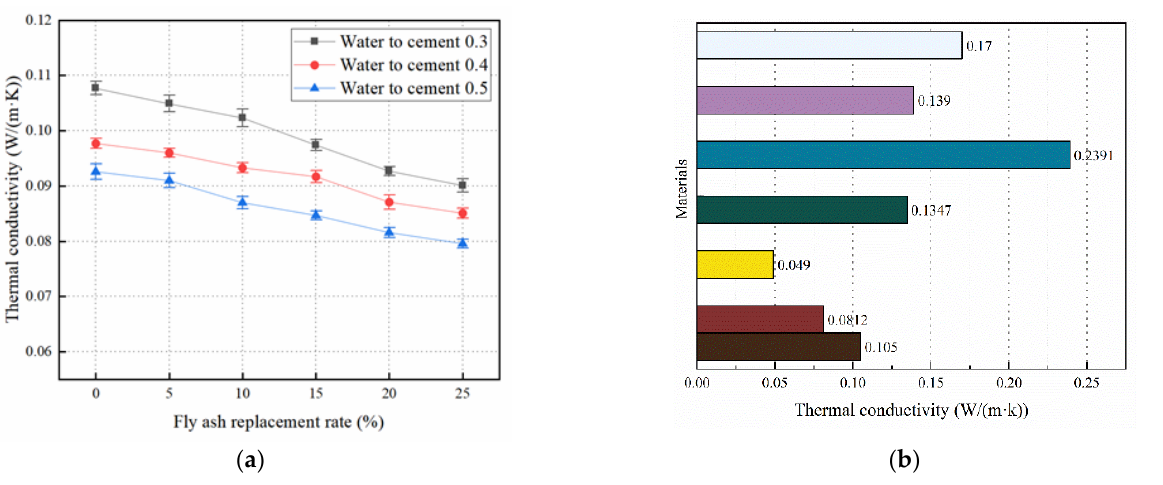
Figure 9. ( a ) Thermal conductivity of foam concrete with different fitting ratios ( b ) Thermal conductivity of different types of foam concrete.